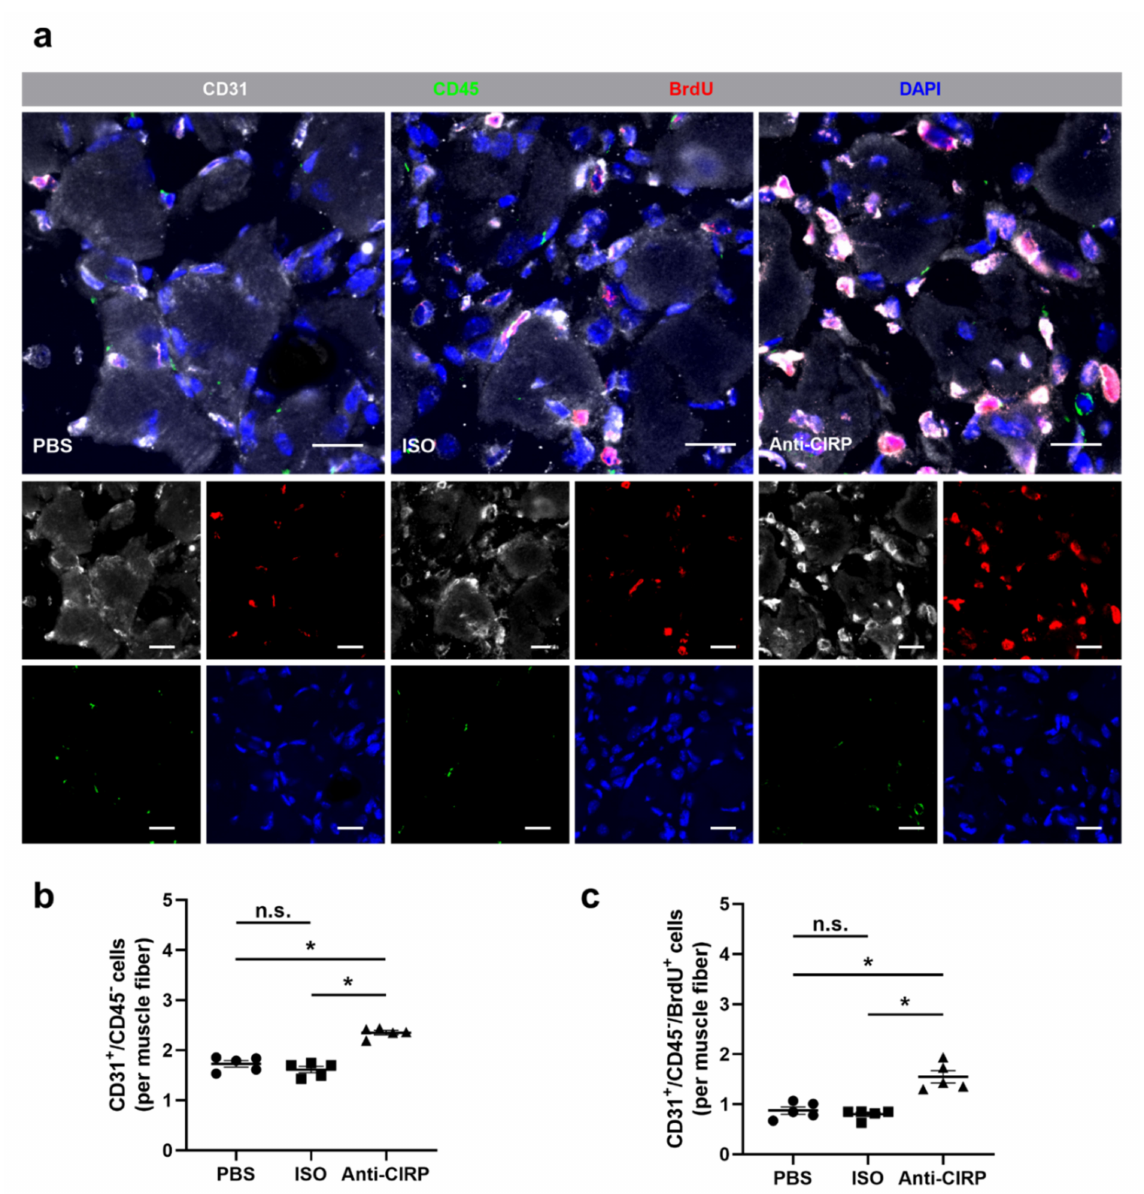
Figure 1. Lack of extracellular “Cold-inducible RNA-binding protein” (eCIRP) enhances capillary growth. ( a ) Representative immunofluorescence stains of ischemic gastrocnemius muscle slices from control mice (treated with phosphate-buffeCDred saline (PBS) or isotype antibody (ISO)), and mice which received anti-CIRP antibody (Anti-CIRP) 7 days after femoral artery ligation (FAL). Smaller images show single channels, large images show all merged channels of endothelial cells (anti-CD31, white), proliferating cells (anti-BrdU (bromodeoxyuridine), red), leukocytes (anti-CD45, green), and nucleic acid (DAPI, blue). Scale bars represent 20 µ m. Scatter plots displaying ( b ) CD31 + /CD45 − (endothelial) cells and ( c ) CD31 + /CD45 − /BrdU + (proliferating endothelial) cells per muscle fiber of ischemic gastrocnemius muscles of PBS-, ISO- (both control groups), and anti-CIRP antibody-treated mice 7 days after FAL. Data are means ± S.E.M., n.s. p > 0.05, * p < 0.05 (PBS vs. ISO vs. anti-CIRP) by one-way ANOVA with the Tukey’s multiple comparisons test, a defined ischemic area (1.5 mm 2 ) of muscle tissue was analyzed per